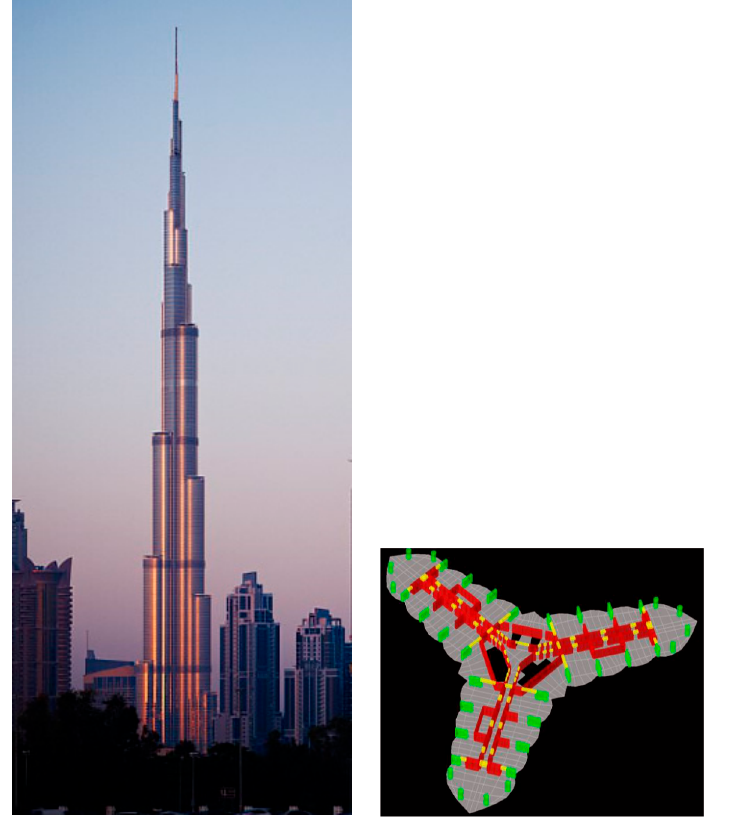
Figure 14. Burj Khalifa (Courtesy of SOM © Nick Merrick for Hedrich Blessing) and its structural layout (Courtesy of SOM © SOM).